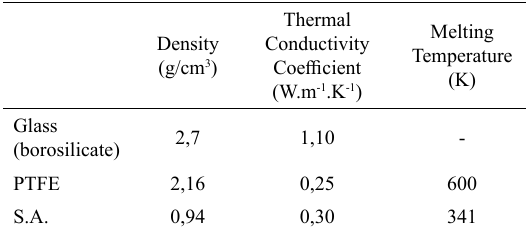
Table 2. Data of materials used 23,24